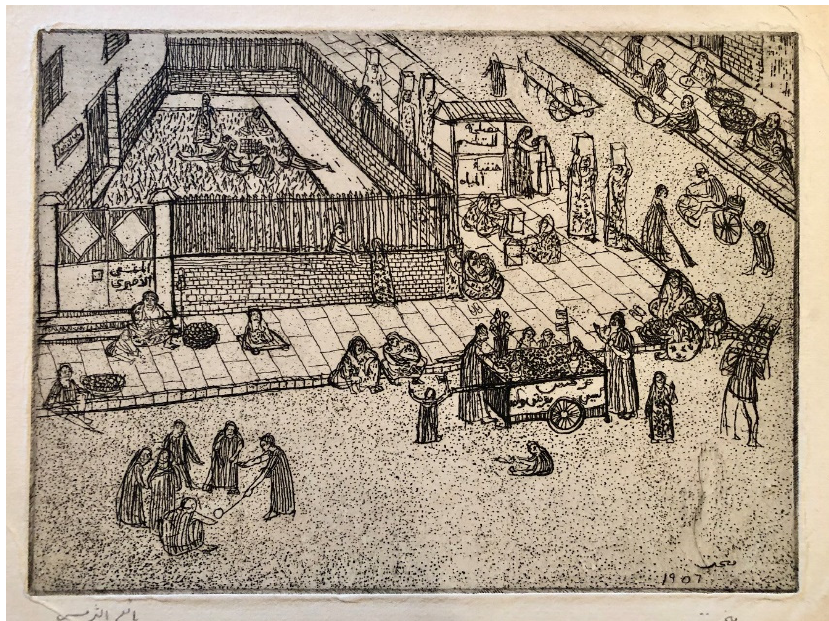
Figure 10. The Lupin Seller (1956). Etching. Courtesy of estate of Menhat Helmy. At the lupin seller’s stall in the front foreground, we notice women customers gath- ered around the wheeled stand, whose sign advertises the termes or lupin beans, sold as a street food snack, while others are seated in various locations engaged around a stick and wheel game. Is this relative safety and calm of the streets reflective of an idealized pano- rama of daily life or is the artist instead choosing to show the mixture of play, work and socializing among the women?